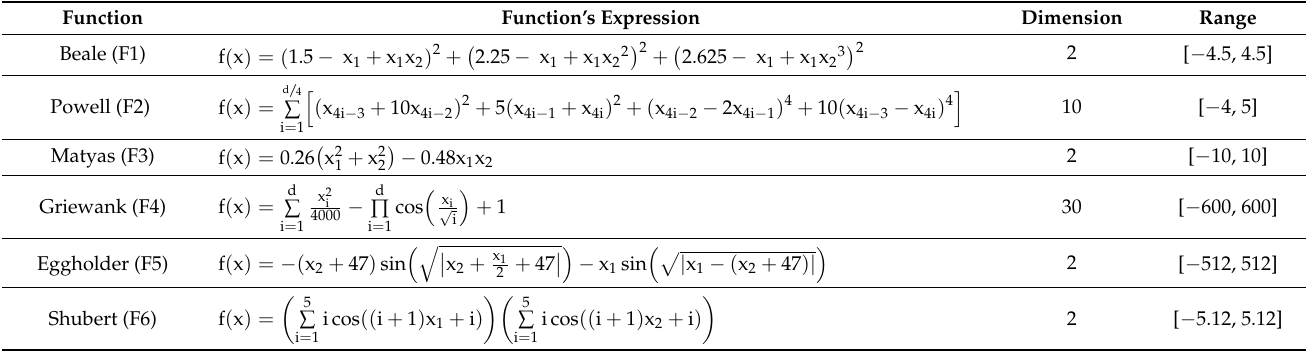
Table 1. Description of benchmark functions used in the study.